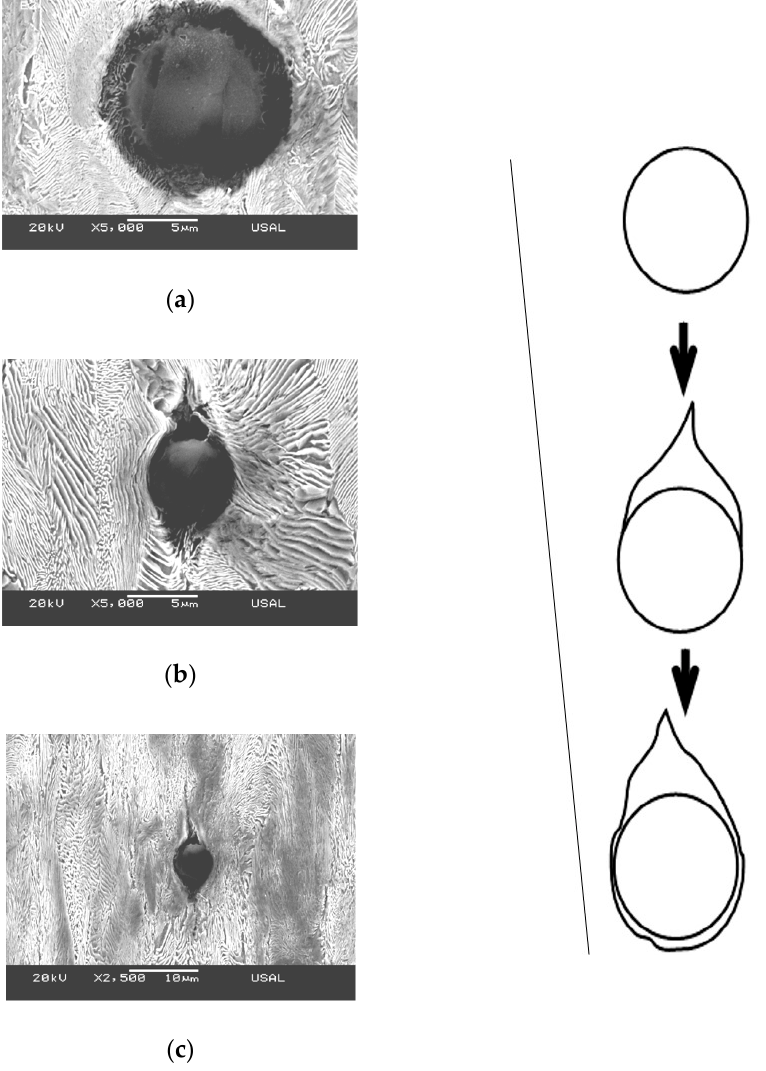
Figure 11. Micrographs and outline of the evolution of hard -type inclusions during the drawing process belonging to the steels E2 ( a ), E4 ( b ) and E7 ( c ). Mix -type inclusions are made up of two typologies of inclusions, one softer and one harder. Both typologies, within the same inclusion, are clearly different by tonality